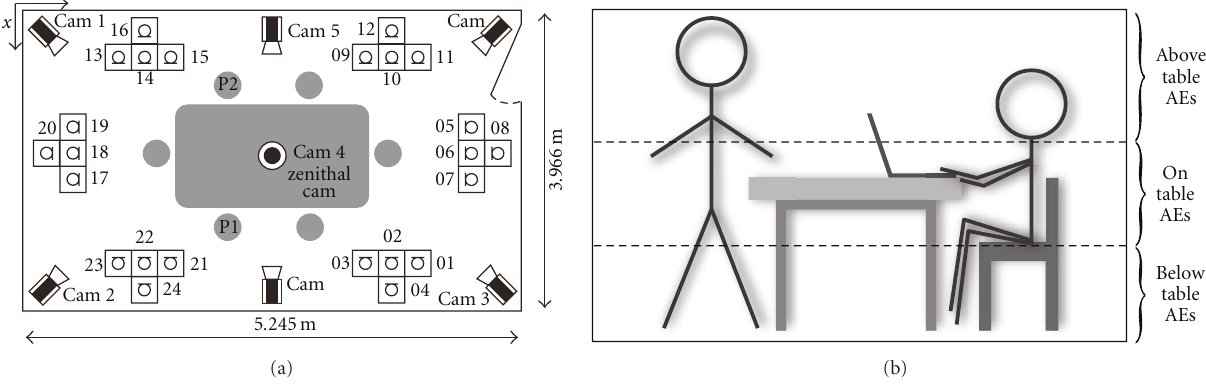
Figure 1: (a) The top view of the room. (b) The three categories along the vertical axis.